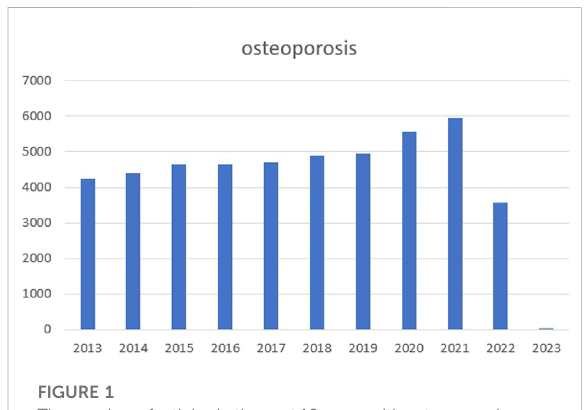
FIGURE 1 The number ofarticles inthepast 10 yearswith